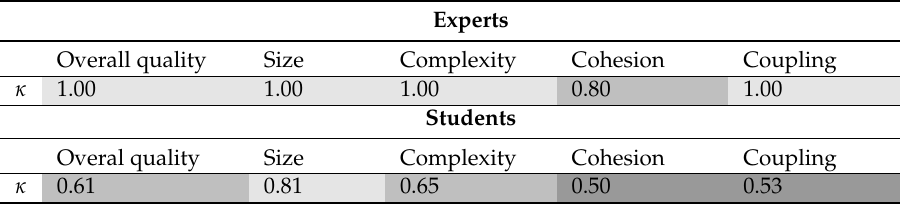
Table 7. Values of Fleiss’s kappa for the measured quality